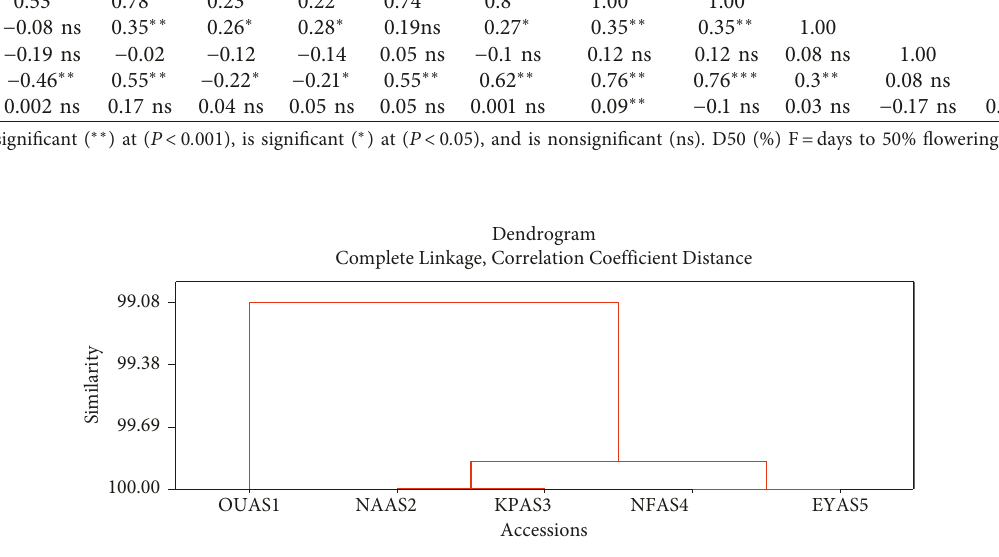
Figure 1: Phenogram showing phenotypic diversity among Fonio accessions.